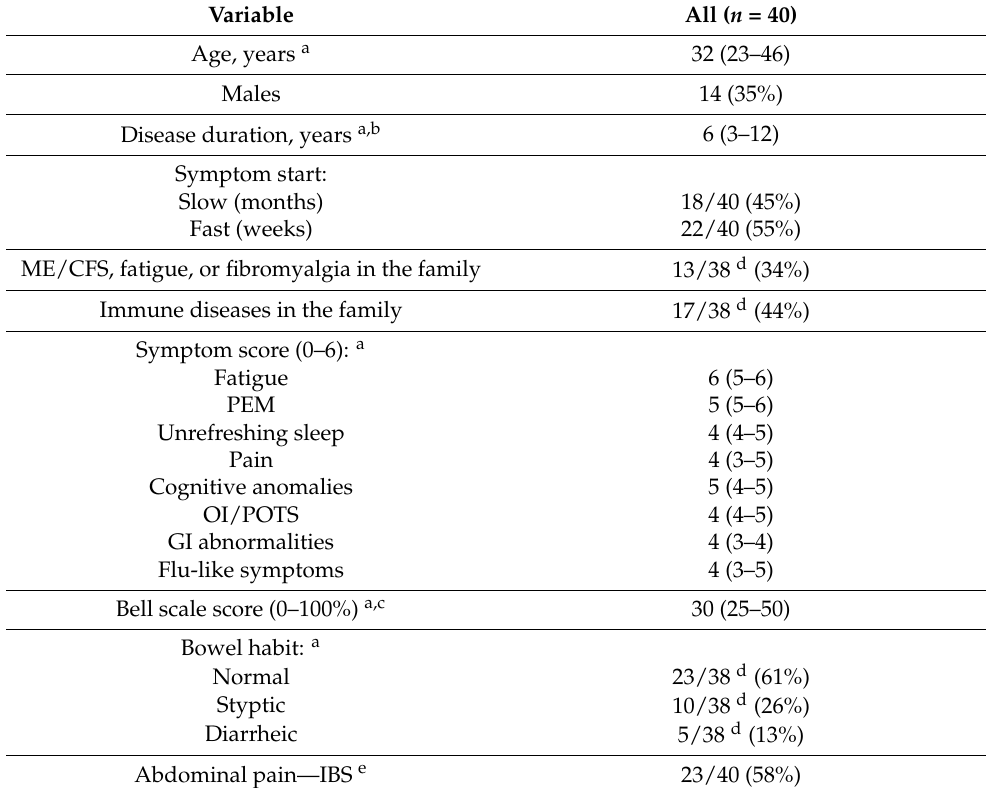
Table 1. ME/CFS patient